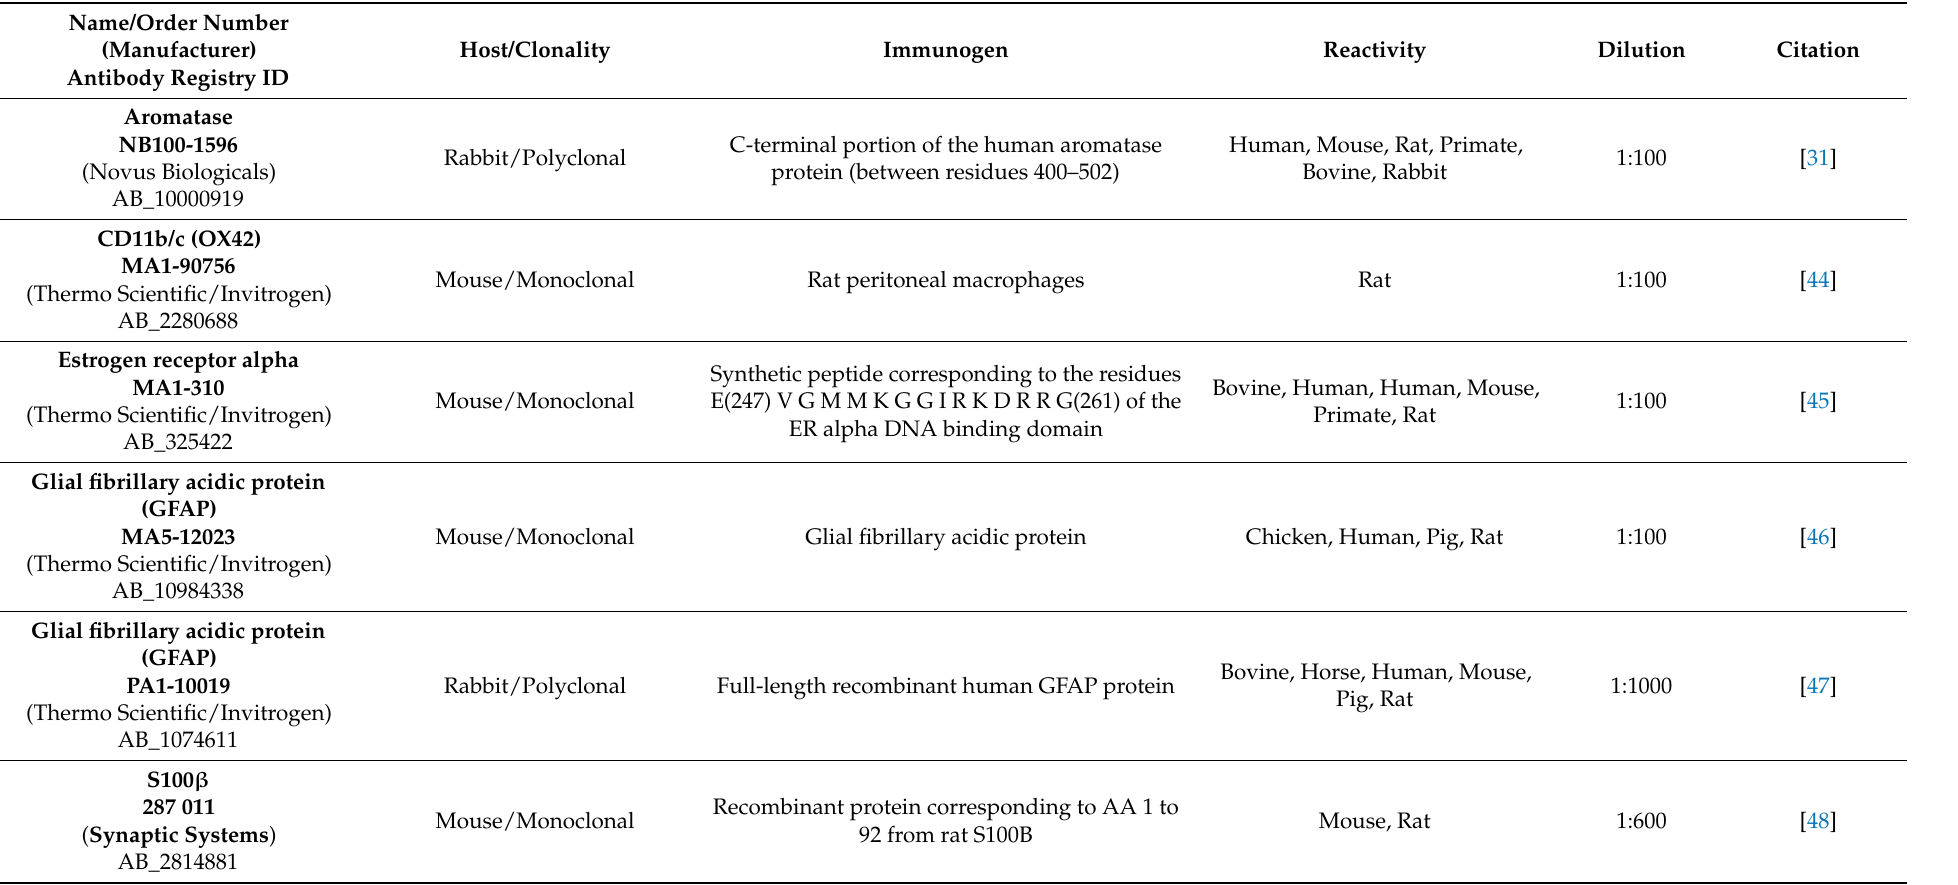
Table 2. List of primary antibodies used in this study. According to the technical information provided by the manufacturers, the commercial primary antibodies used in the study were verified by Knockdown or Relative expression to ensure that the antibody binds to the antigen